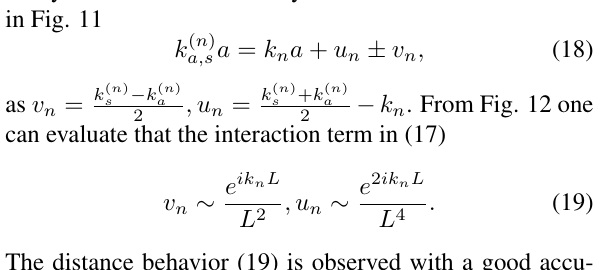
Figure 11: (a) The behavior of resonant eigenfrequencies under variation of the distance between the disks L with the ϵ = 40 , a = h . (b) and (d) zoomed areas highlighted in (a) with symmetric (solid lines) and antisymmetric (dash lines) resonant modes. (c) and (e) show the behavior of the Q factor vs the distance for corresponding insets at the left. Closed circles mark the eigenfrequencies of isolated disks and respectively the Q factors while crosses mark the limiting case L = h when two disks stick together.